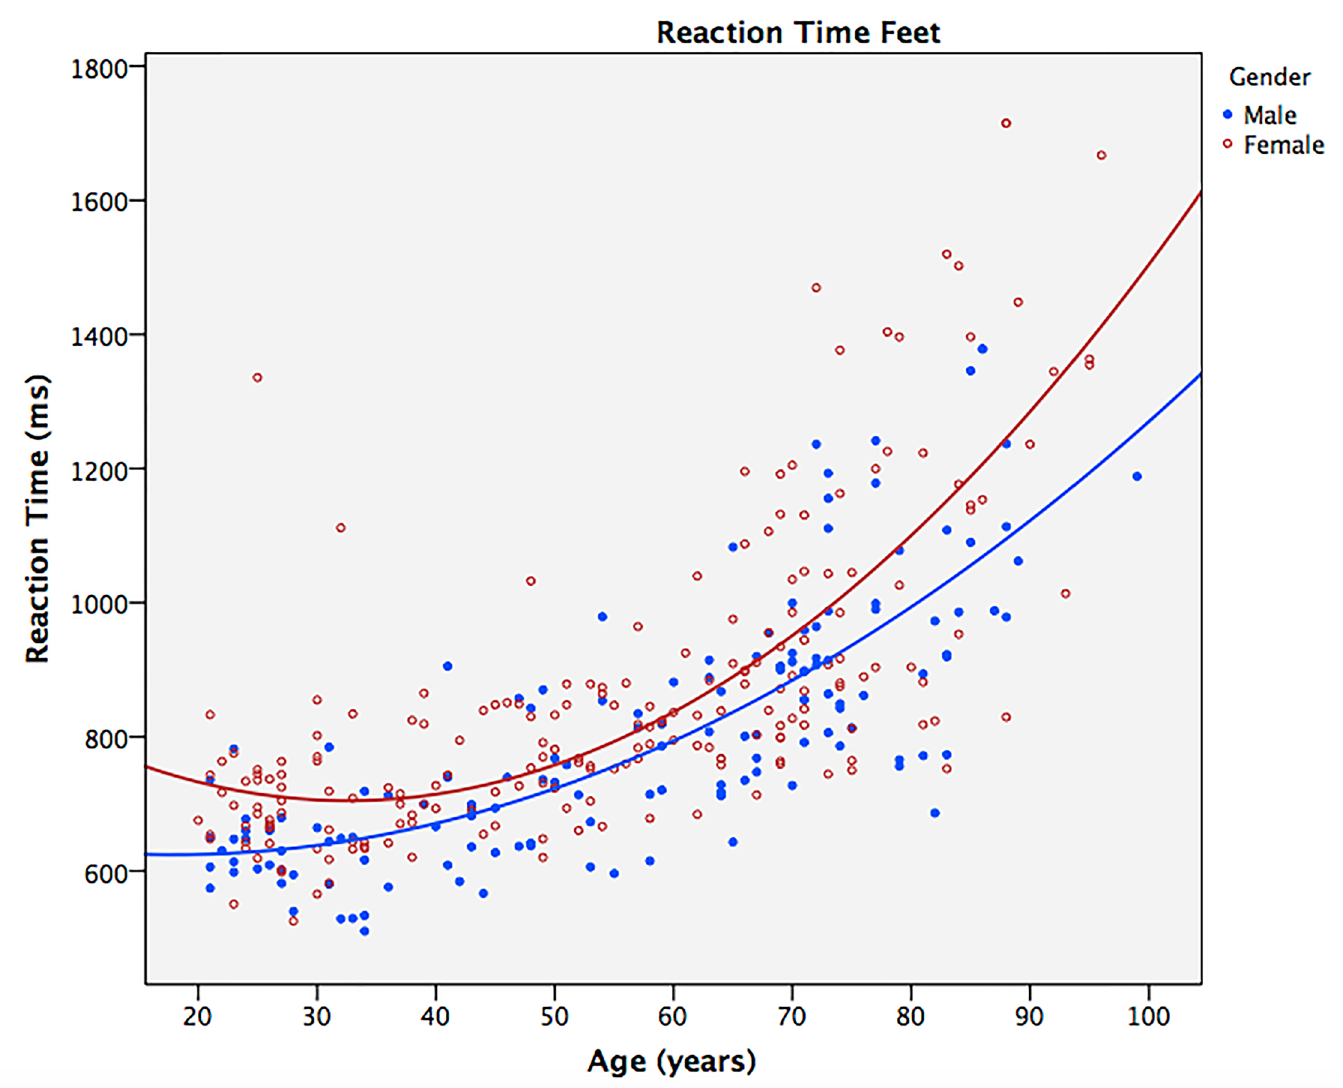
Fig 2. Reaction time feet: data points and quadratic